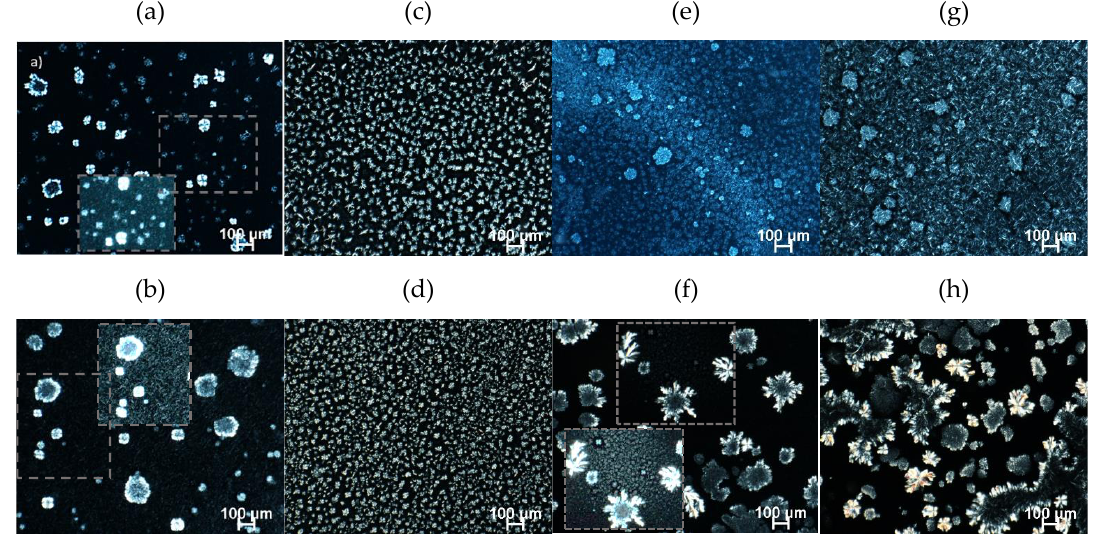
Figure 5. Polarized light microscopy of mixed oleogels with total oleogelator concentration of 6% ( w / w ). Top: 5 °C and bottom: 25 °C. GMS25:75BEW ( a , b ); GMS25:75SHW ( c , d ); GMS50:50SHW ( e , f ), and GMS75:25SHW ( g , h ).